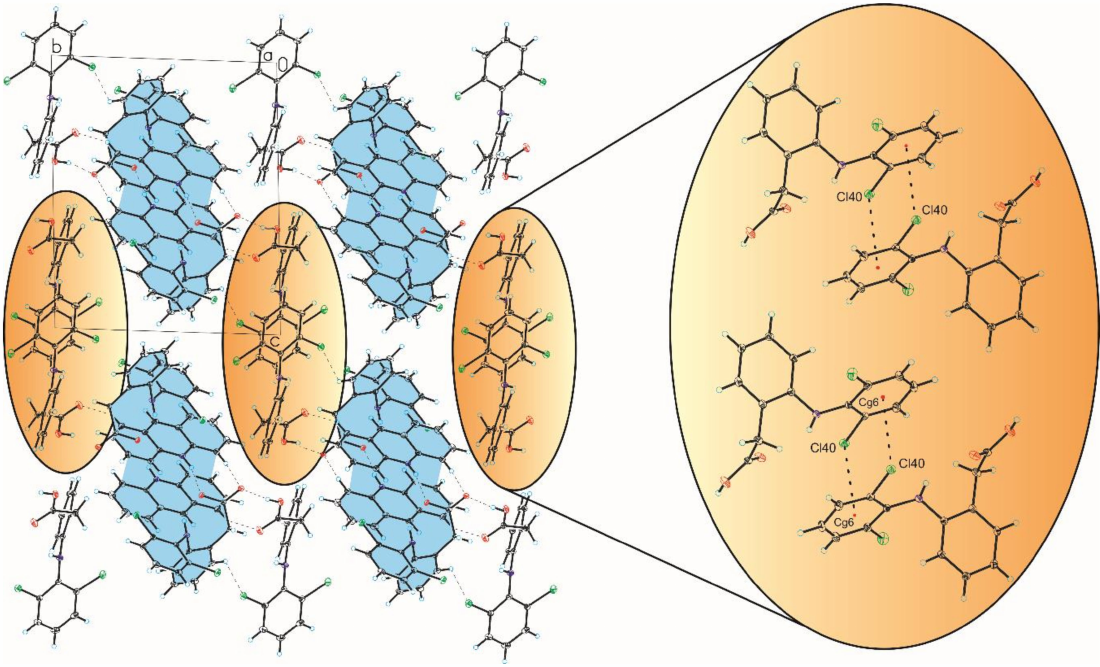
Figure 3. Crystal packing of compound 1 viewed along the a -axis (hydrogen bonds are represented by dashed lines, whereas C–Cl · · · π interactions are represented by dotted